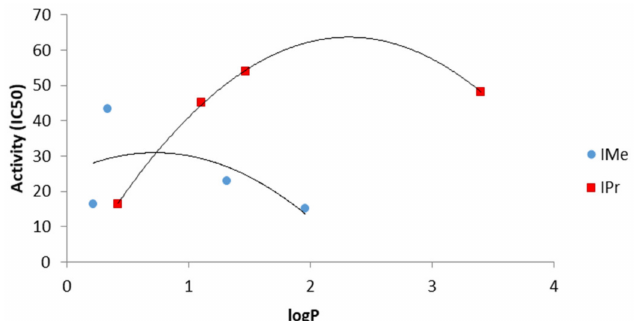
Figure 4. Correlation between cytotoxic activity of the complexes and logP.